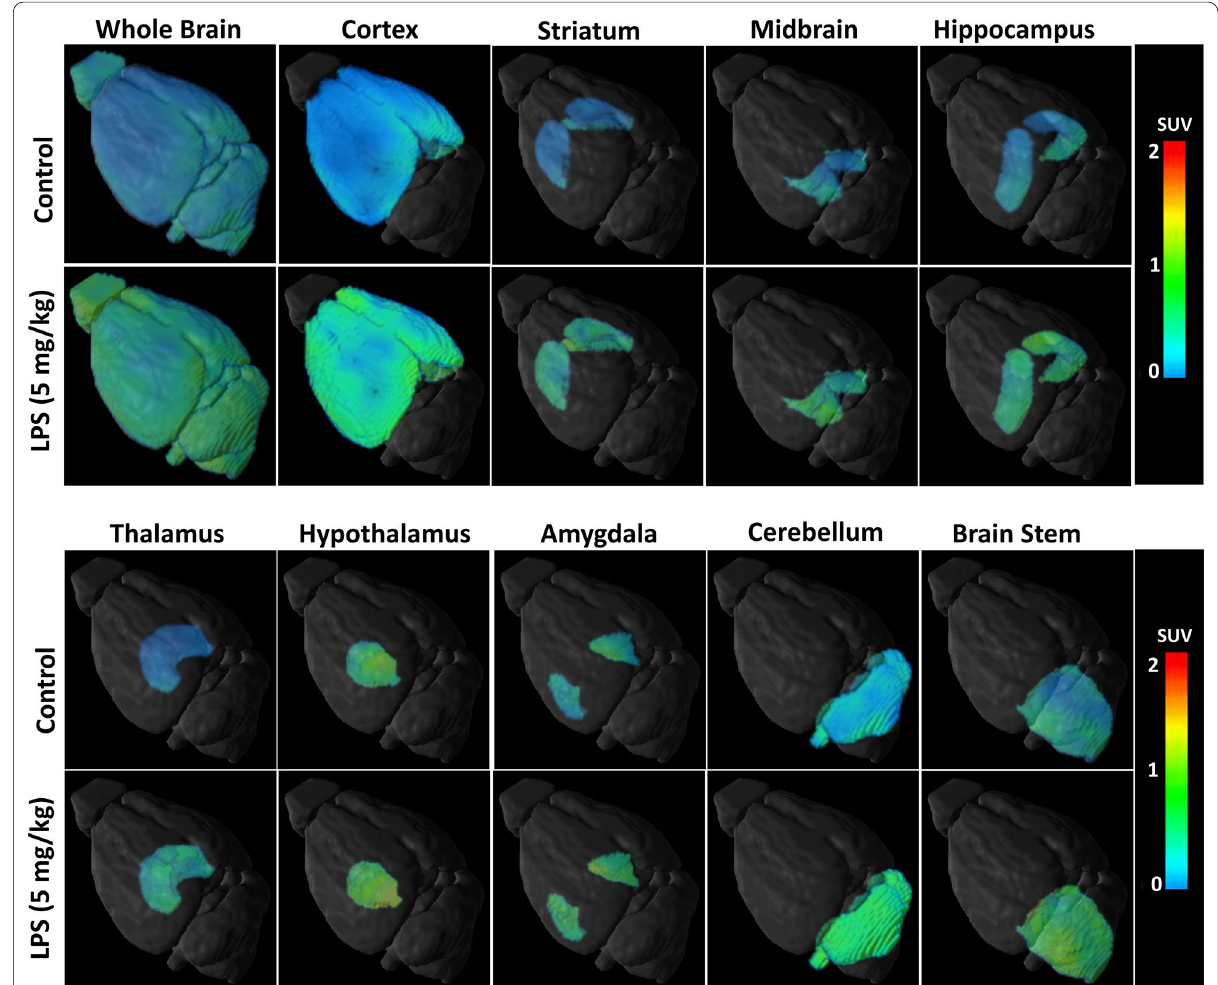
Fig. 3: 3D PET/MRI images of the brain obtained 30 min after i.v. administration of [ 18 F]FEPPA in control and 24 h LPS‑injected animals (5 mg/ kg, i.p.). Significantly higher [ 18 F]FEPPA uptake was observed in all brain regions of the LPS group at 24 h compared to the control group. [ 18 F] FEPPA TSPO binding were more region‑specific or globally distributed in the brain. PET images were generated by summation of the whole scan (0–30 min); the mean SUV value of each group is represented and color‑coded to the range of SUV values ( n